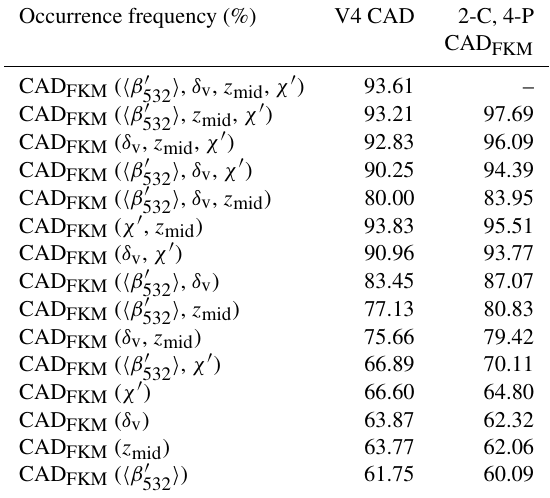
Table 4. Statistics of joint occurrence frequency during Jan- uary 2008 from 60 ◦ S to 60 ◦ N between the COCA V4 classifica- tions and the FKM classifications based on limited input parameter sets (i.e., one, two, or three CALIOP measurements, as listed in the left column), the COCA V4 classifications (center column), and the two-class, four-parameter (2-C, 4-P) CAD FKM classifications (right column).